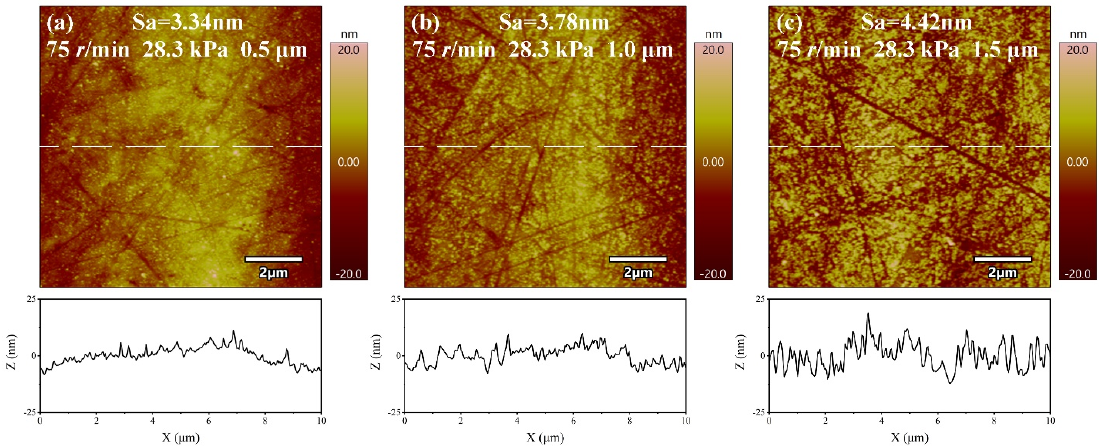
Figure 6. AFM images of amorphous alloy surfaces after polishing experiments with different par ‐ ticle sizes. ( a ) 0.5 μ m; ( b ) 1 μ m; ( c )1.5 μ m.